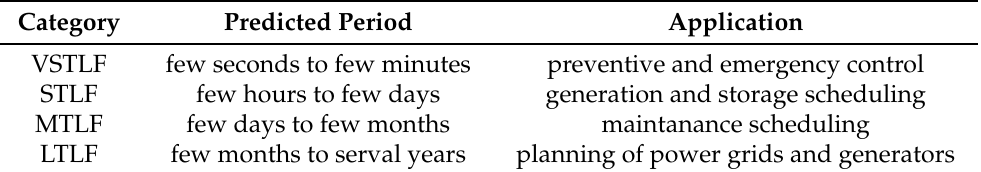
Table 1. Categories of load